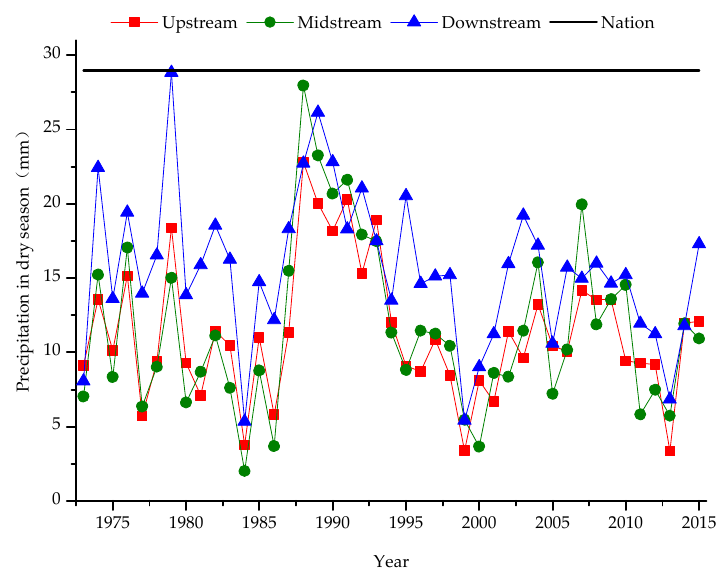
Figure 5. The precipitation in the dry season at upstream, midstream and downstream sections in MSX from 1973 to 2015. The upstream meteorological stations include Longxian and Baoji, the midstream include Fengxiang, Wugong, Qindu and Xi’an, and the downstream include Jinghe, Yaoxian, Tongchuan, Pucheng, Huaxian, and Huashan. The precipitation data from the upstream, midstream and downstream sections are the average values of the abovementioned stations over the same period. The national precipitation data are the long-time average annual values of China. All the precipitation data were provided by the National Meteorological Information Center of China.